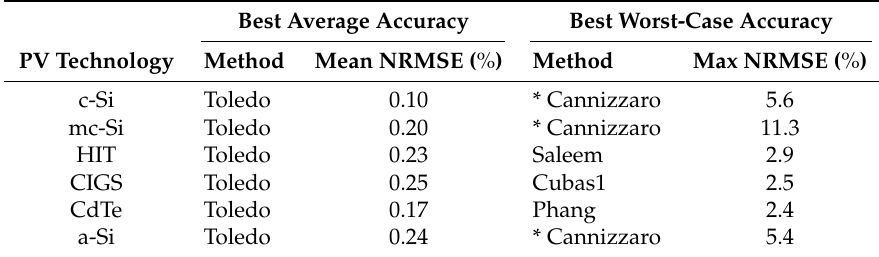
Table 4. Most accurate methods for each PV